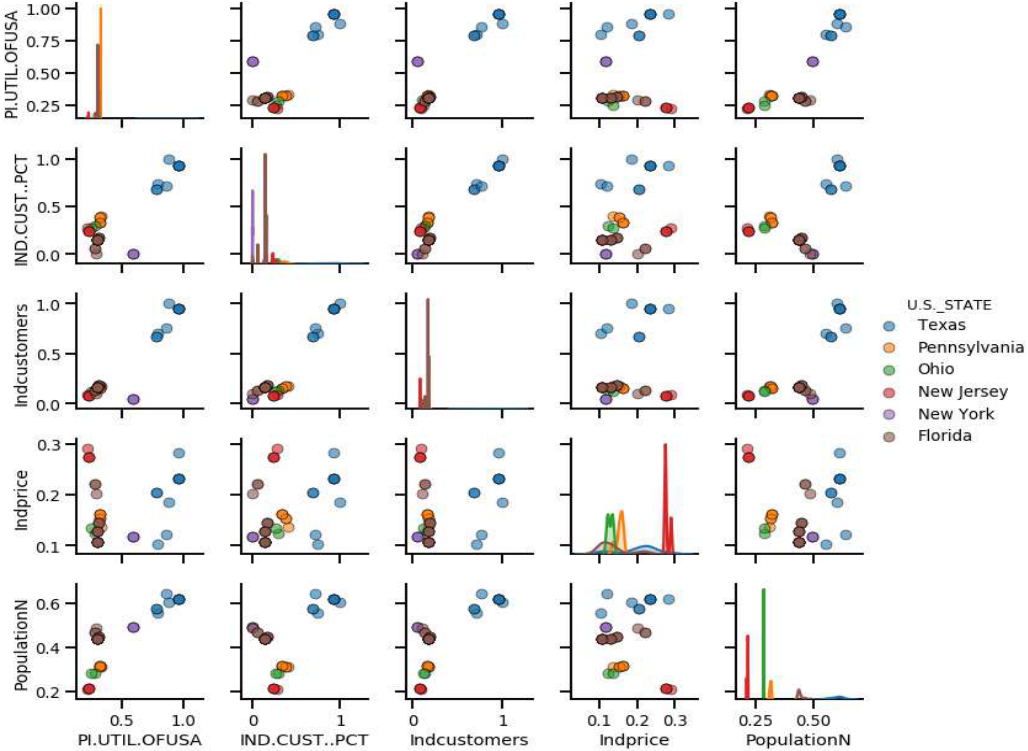
Figure 11. Correlation plot of the top five influential features for the hurricanes disaster category.